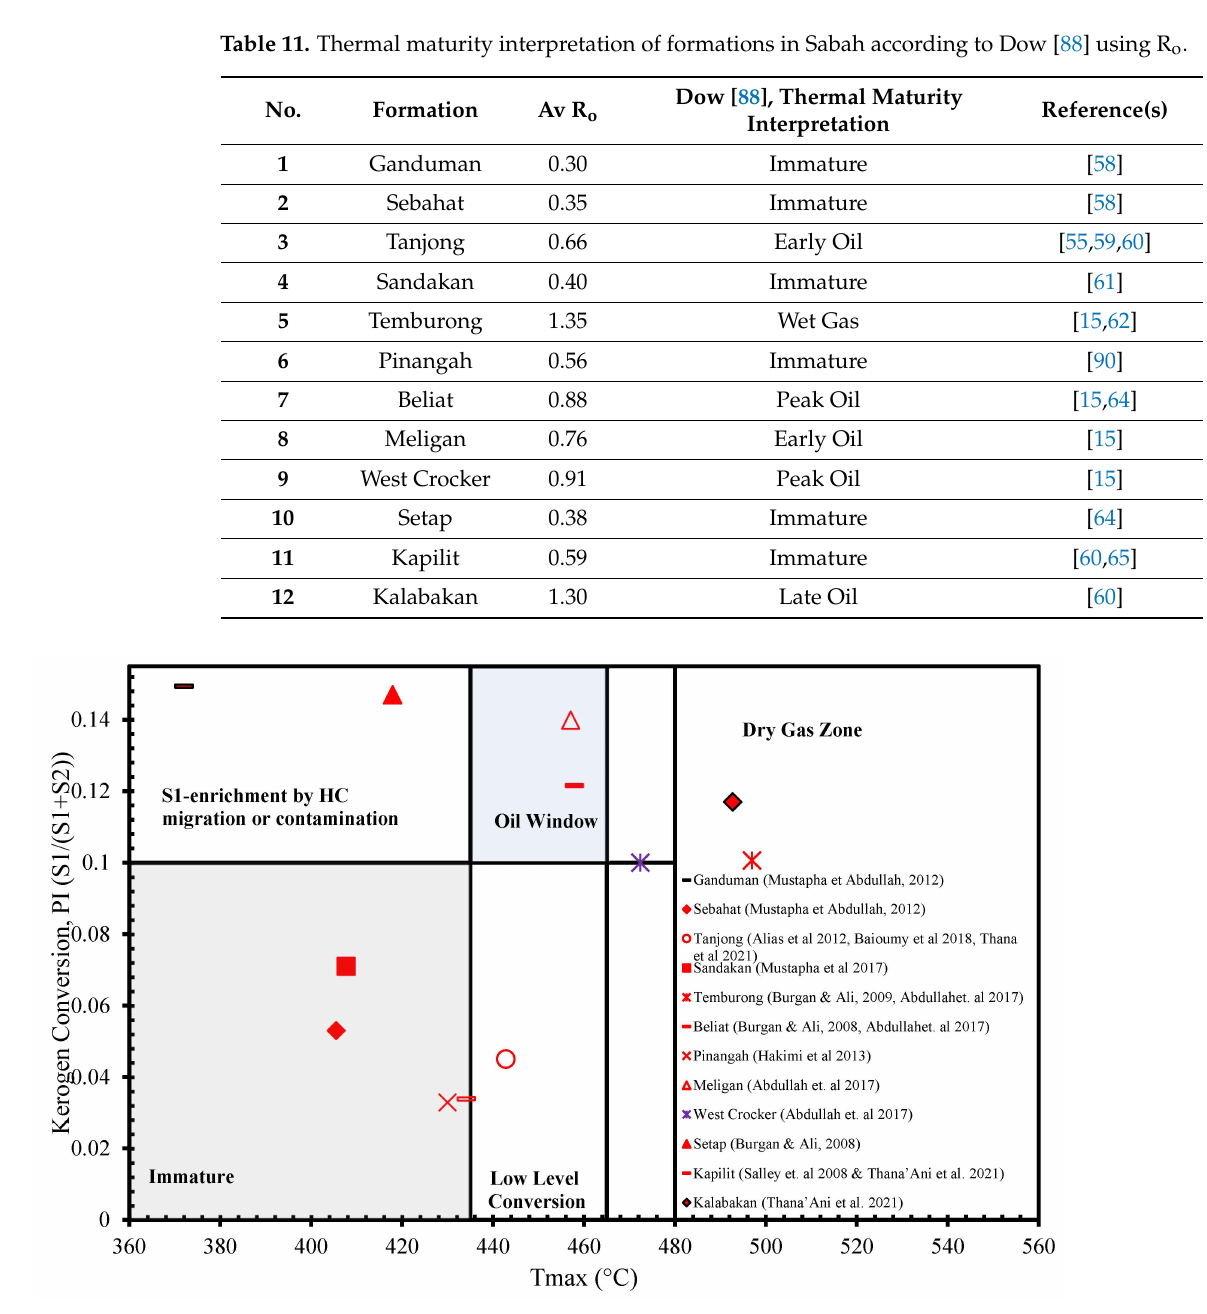
Figure 12. Tmax versus PI plot showing the level of kerogen maturity of formations in